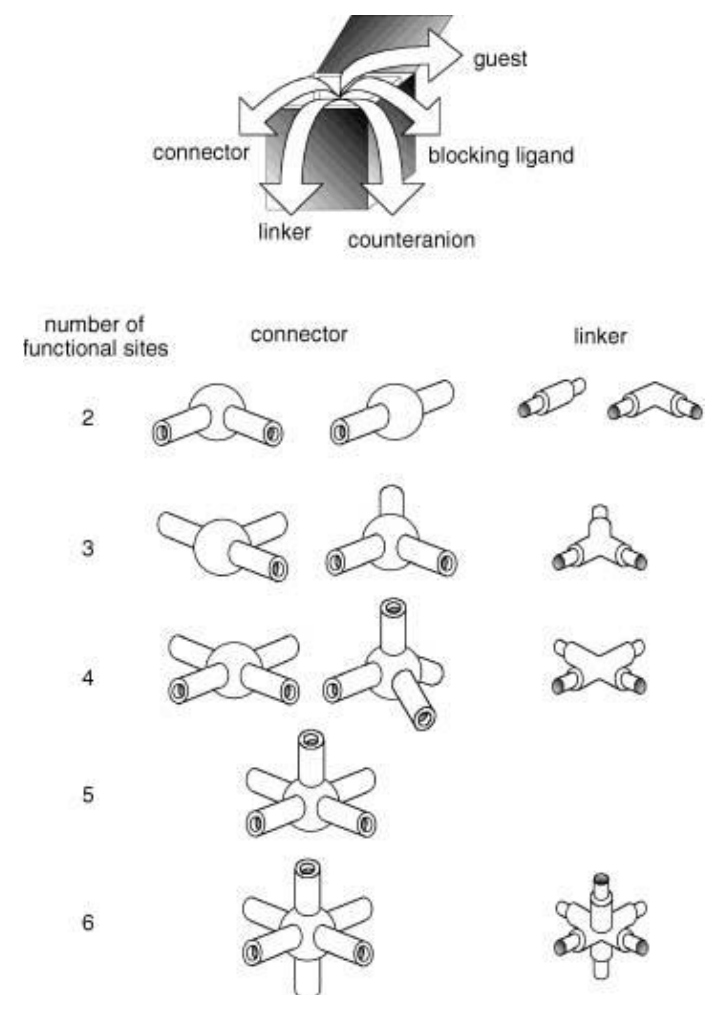
Figure 1. Geometrics of metal ions and organic ligands. Reprinted with permission from [9]. Copyright 2004 WILEY-VCH Verlag GmbH & Co. KGaA, Weinheim.